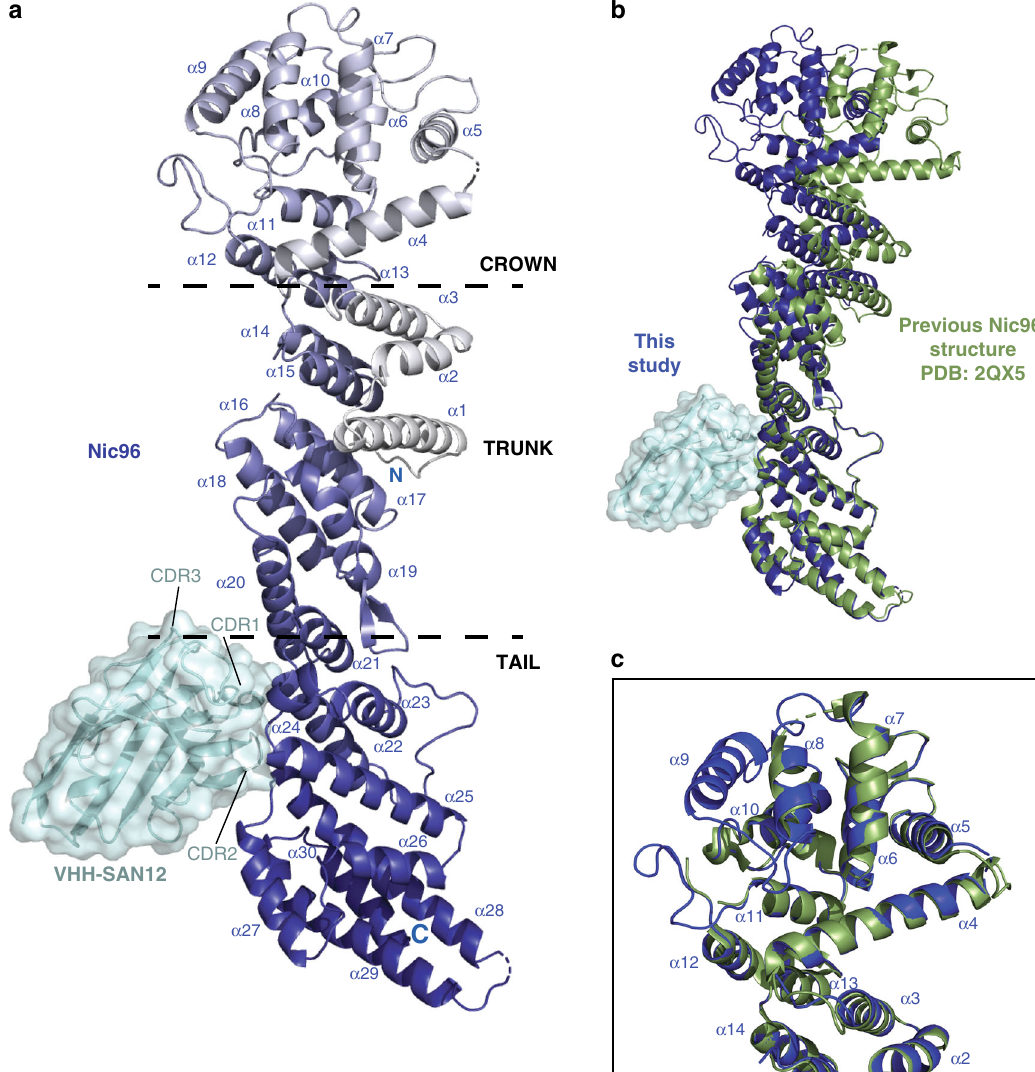
Fig. 5 Structure of Nic96-VHH-SAN12 highlights the fl exibility of the ACE1 fold. a The structure of Nic96-VHH-SAN12. Nic96 is shown in gradient color from white to dark blue and VHH-SAN12 is shown in light blue. Helices are labeled on Nic96, along with the complementarity determining region (CDR) loops on VHH-SAN12. Boundaries of the ancestral cotamer element (ACE1) fold modules are indicated by the dashed lines. b Superposition of Nic96 with the previously solved structure (PDB: 2QX5 37 ) (shown in green). The alignment was done only in the tail module of the protein. c Superposition of the Nic96 crown module between the two structures. This structure of Nic96, shown in dark blue and the previous structure, shown in